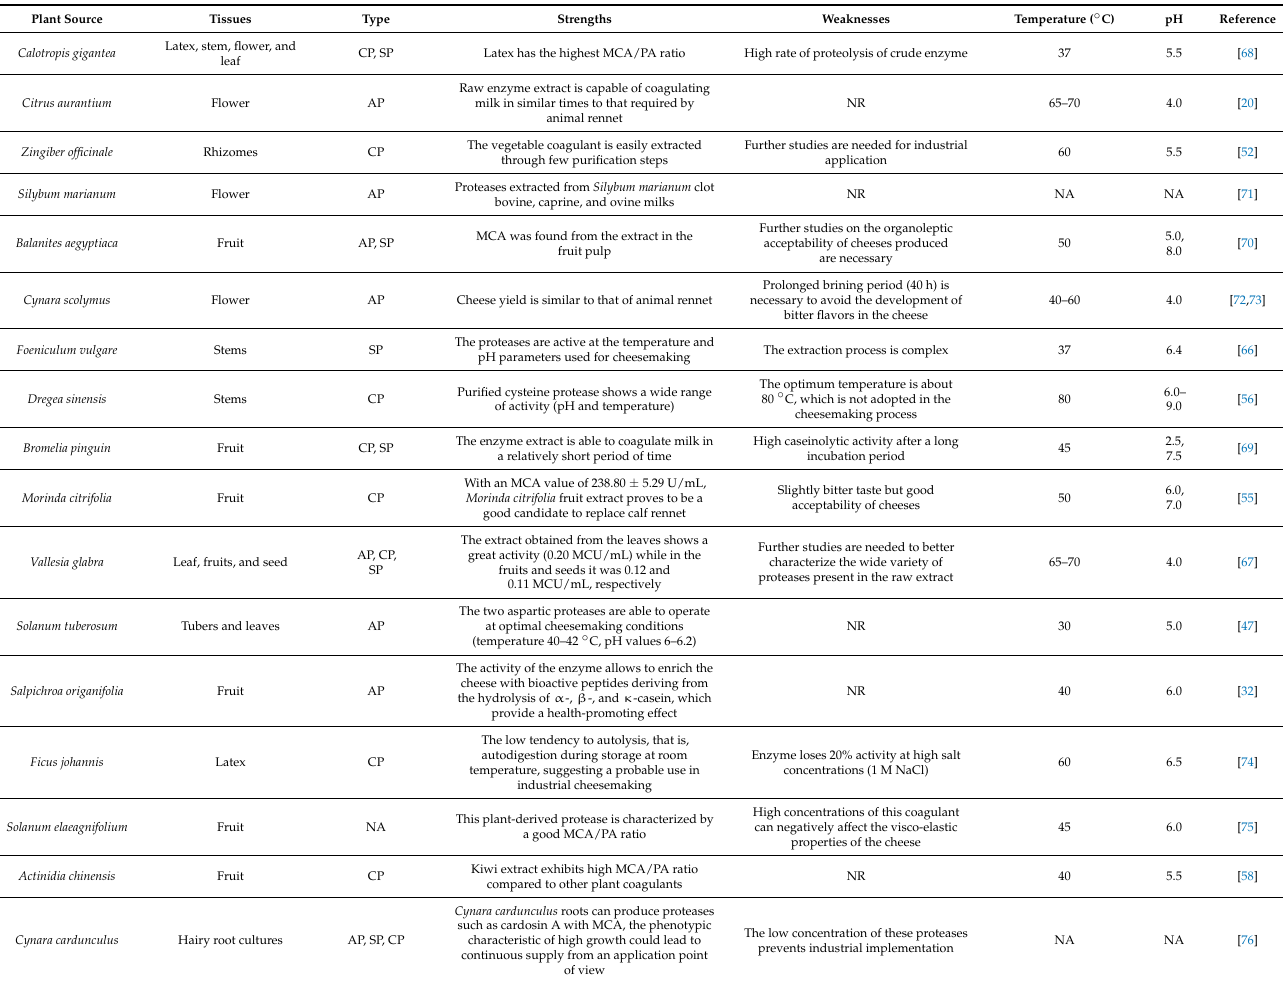
Table 1. Strengths, weaknesses, and optimum pH/temperature of plant proteases recently